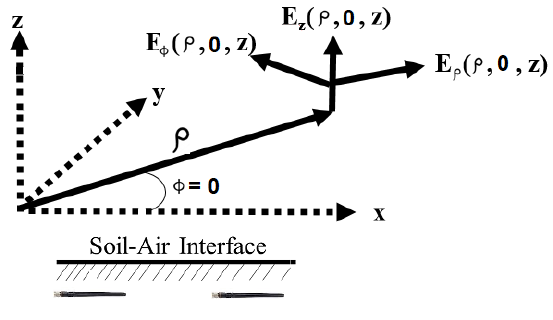
Figure 2. The coordinates for a lateral wave at the surface, φ =